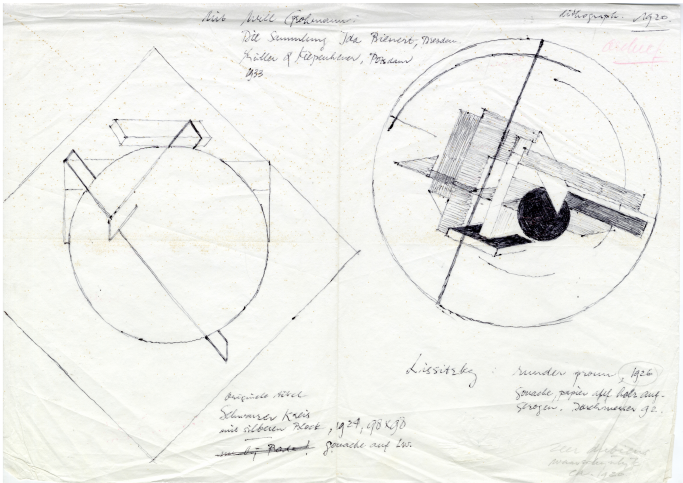
Figure 1. Jean Leering, one of a series of drawings after Lissitzky’s ‘Prouns’, Van Abbemuseum exhibition archive, inv. nr.